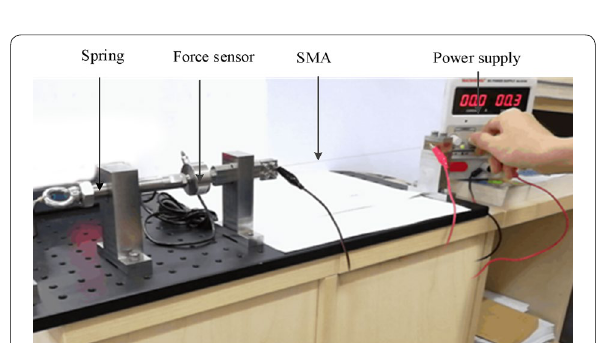
Figure 19 Performance testing platform of the SMA